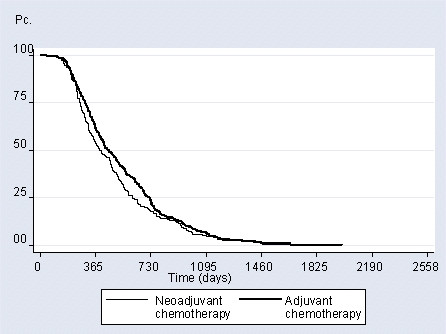
Progression-free survival for patients with stage III and IV ovarian cancer in the neoadjuvant chemotherapy and adjuvant chemotherapy groups.